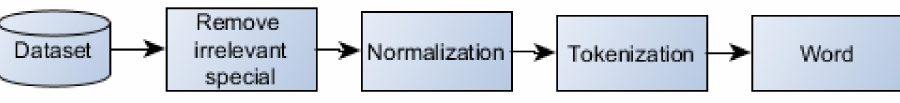
Figure 1. Hate speech detection architecture.